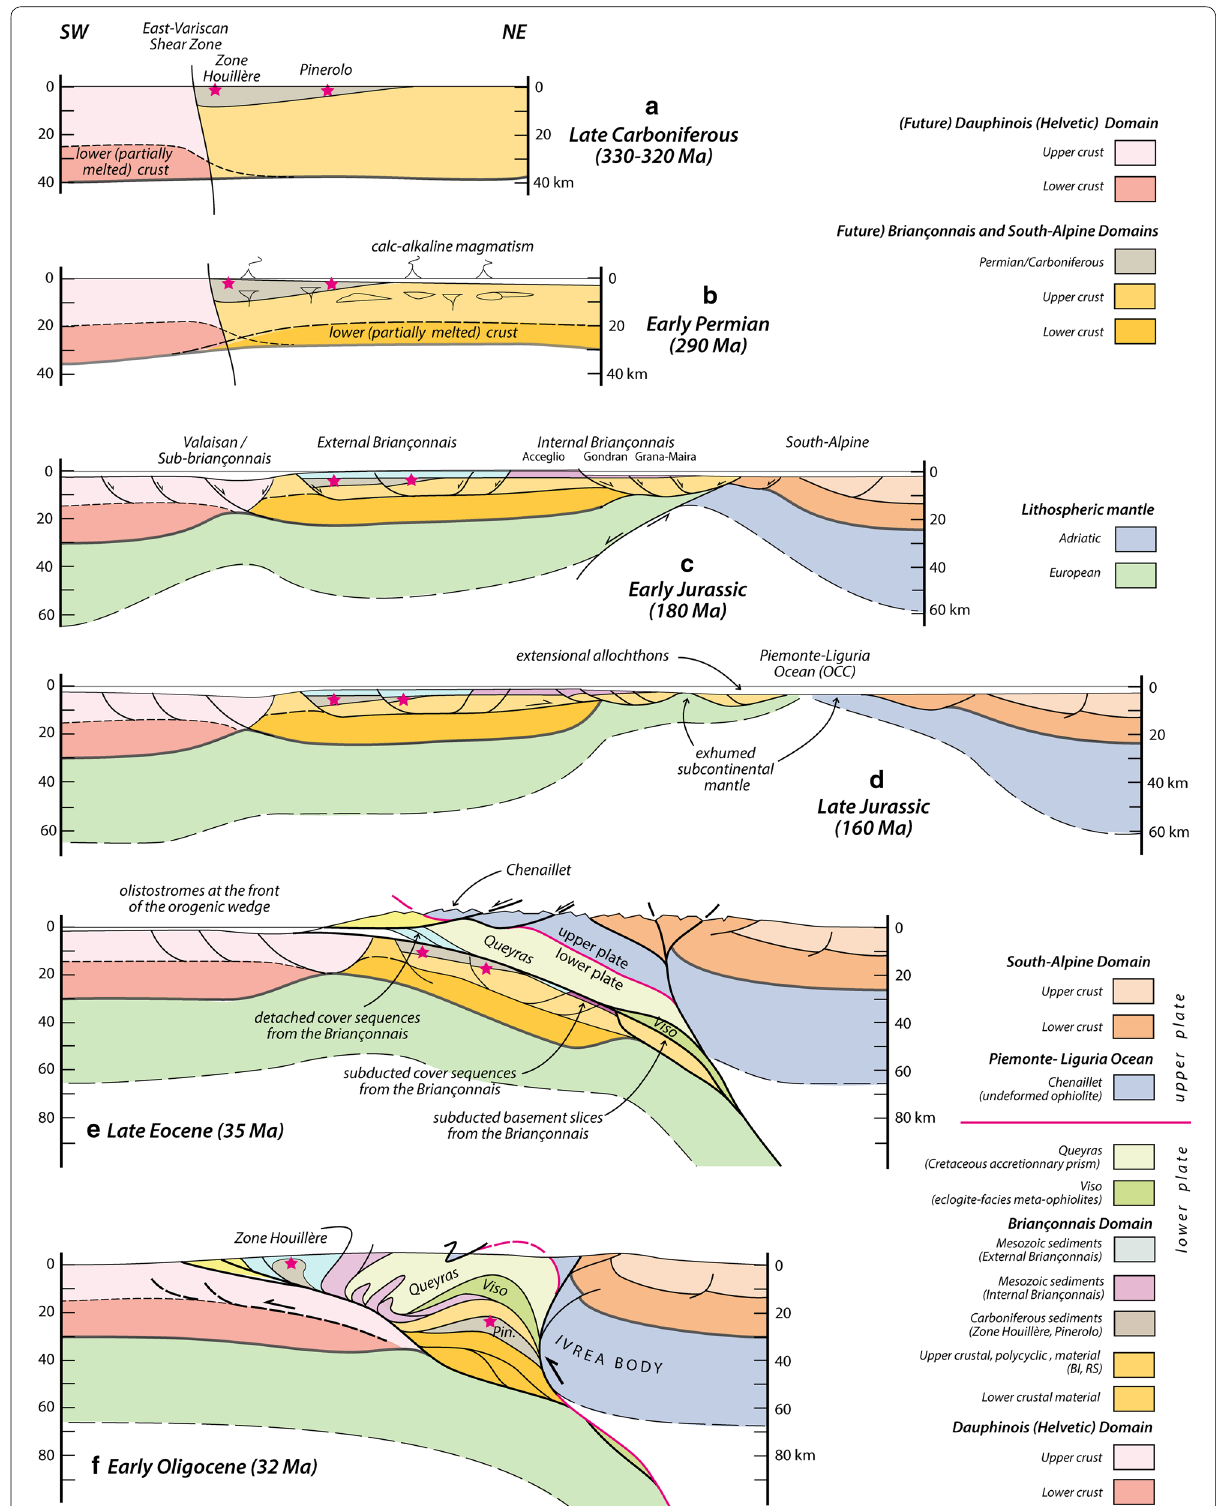
Fig. 13 Key steps in the history of the studied samples. See text for detailed